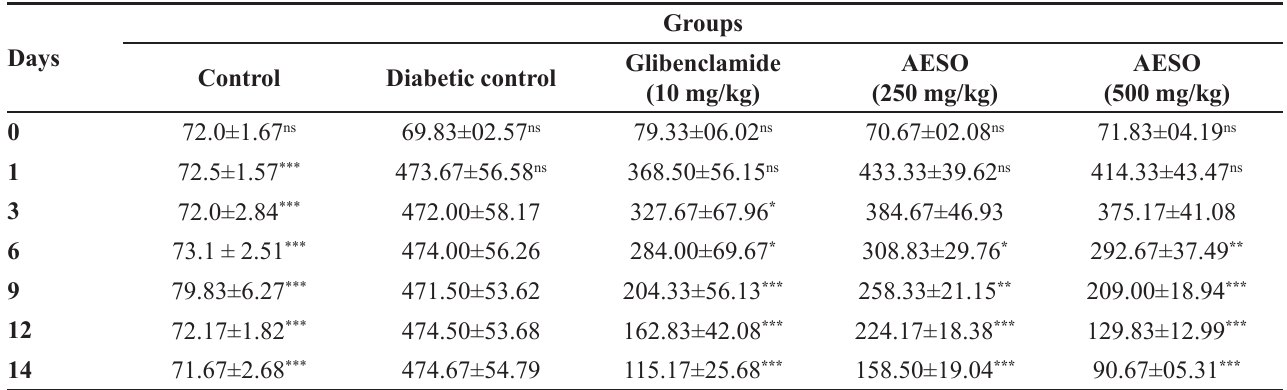
TABLE II - Effect of aqueous extract of Sigesbeckia orientalis on blood glucose levels in control and experimental groups at different